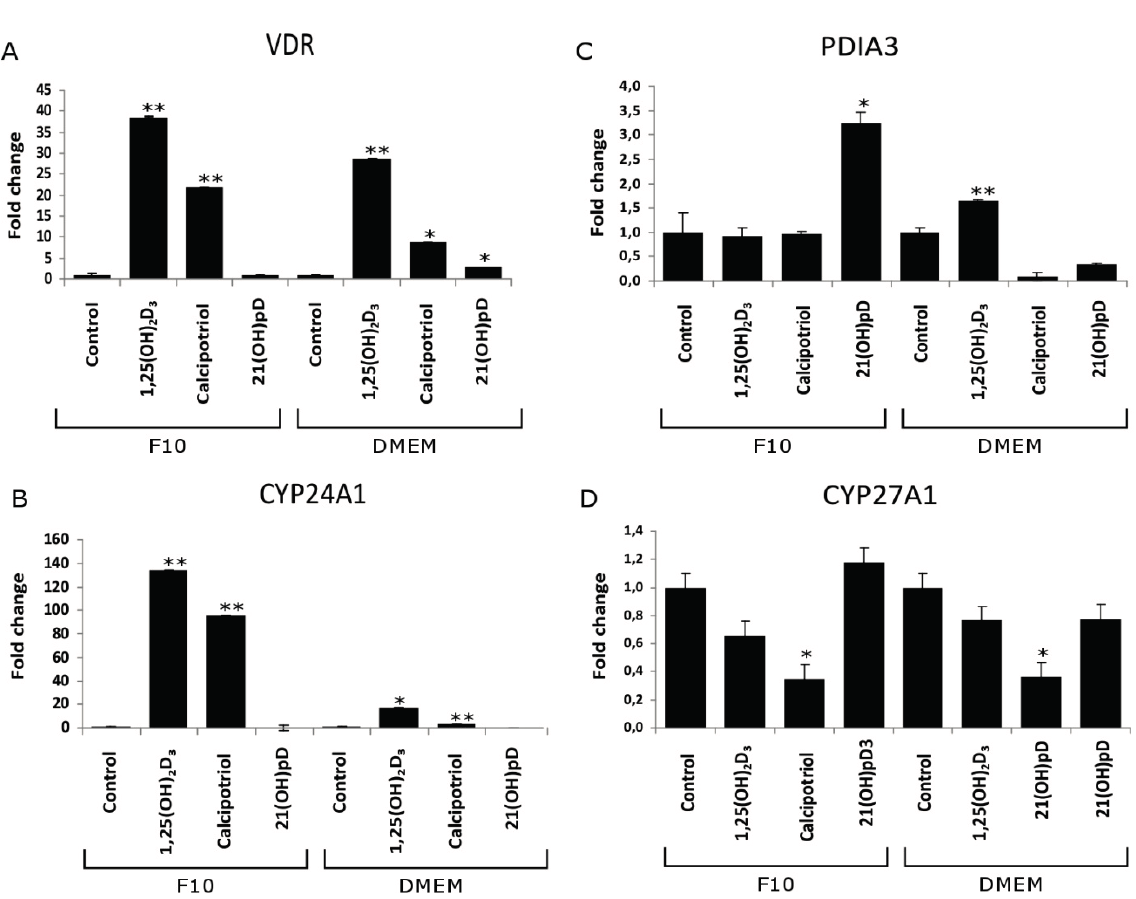
Figure 7. Influence of 1,25(OH) 2 D 3 , calcipotriol and 21(OH)pD on the expression of VDR , PDIA3 , CYP24A1 and CYP27A1 genes in pigmented and non-pigmented B16-F10 melanoma cells. VDR ( A ); PDIA3 ( B ); CYP24A1 ( C ) and CYP27A1 ( D ) mRNA